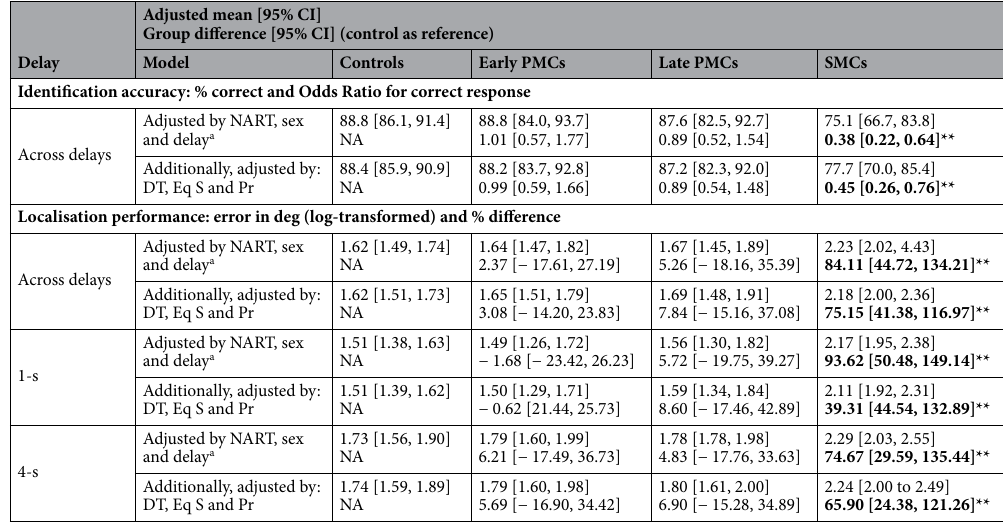
Table 3. Visual exploration strategies as predictors of VSTM performance. PMC presymptomatic mutation carrier, SMC symptomatic mutation carrier, CI confidence intervals, DT total dwell time on fractals, Eq Equality, S total number of shifts between fractals, Pr proportion of time spent looking at the target, NA not applicable. a In order to allow for comparison between models, participants with a score > 2.5 SD in a visual exploration strategy metric (n = 2) were excluded. Of note, as delay did not have a significant effect on identification accuracy investigations were not pursued by delay for this metric. Bold = significant; **significant at p <